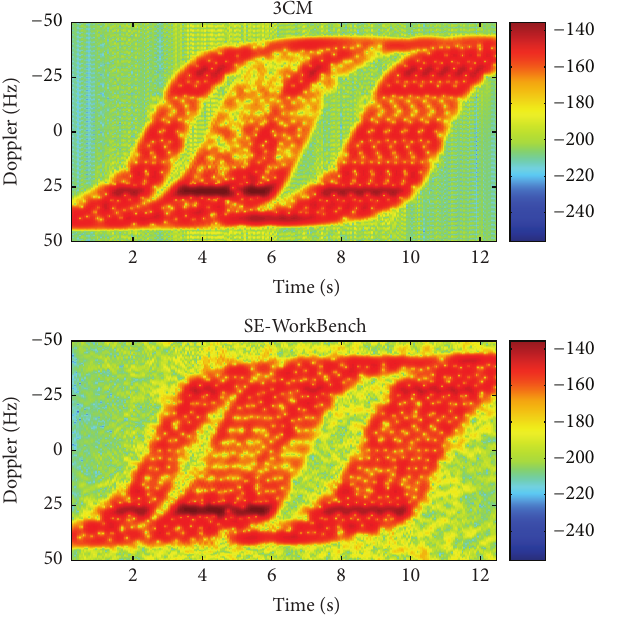
Figure 12: Spectrogram along receiver trajectory.